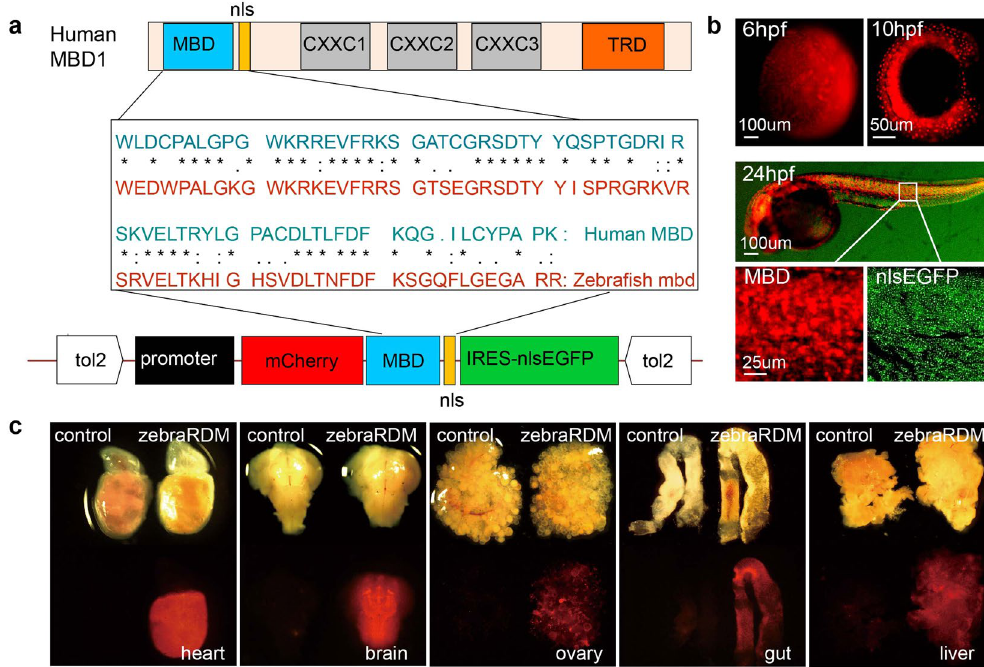
Figure 1. Generation of a zebrafish reporter ubiquitously expressing mCherry-MBD. ( a ) The structure of human MBD1, a comparison of the amino acid sequences of human and zebrafish methyl-binding domains, and the Tol2-based vector structure including promoter, the mCherry-MBD probe, and IRES-nlsEGFP. MBD, methyl binding domain; nls, nuclear localization signal; CXXC, cysteine-rich domains; TRD, transcriptional repression domain. ( b ) Fluorescence images of Tg( bactin2:mCherry-MBD-IRES-nlsEGFP ) F1 embryos at 6, 10, and 24 hpf. Magnified images in white boxes display the mCherry-MBD channel (left) and IRES-nlsEGFP channel (right). ( c ) The distribution of mCherry-MBD in the adult zebrafish heart, brain, liver, ovary, and gut. The reporter is labeled as